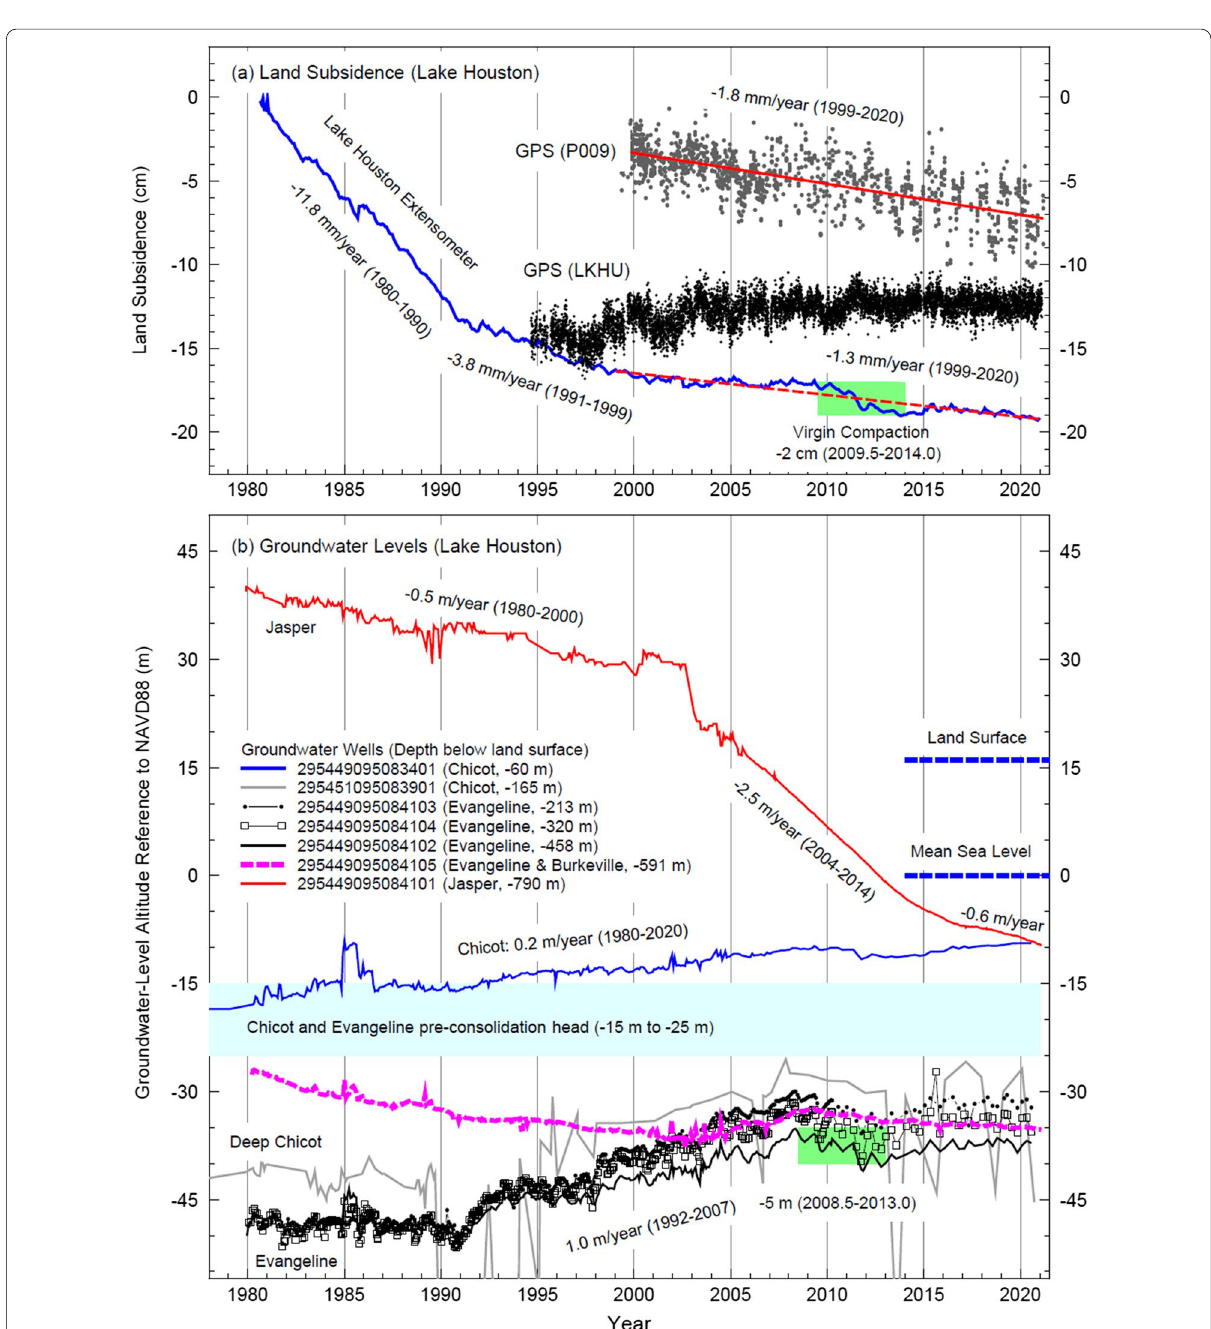
Fig. 11 Land subsidence and groundwater-level changes at the Lake Houston site. The green box indicates the virgin-compaction phase. The relative locations of wells, extensometer, and GPS are illustrated in Fig. 10. The location of GPS station P009 is marked in Fig.